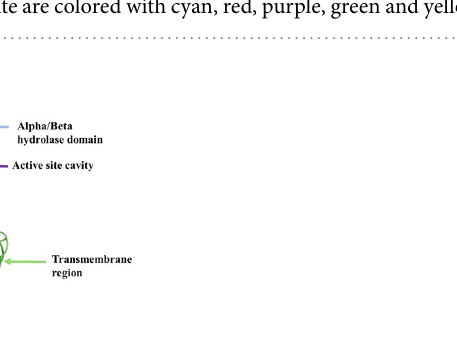
Figure 2. Overall structure of AlucJHEH . Alpha/Beta hydrolase domain, Epoxide hydrolase domain, Active site cavity, transmembrane region and active site are colored with cyan, red, purple, green and yellow, respectively.